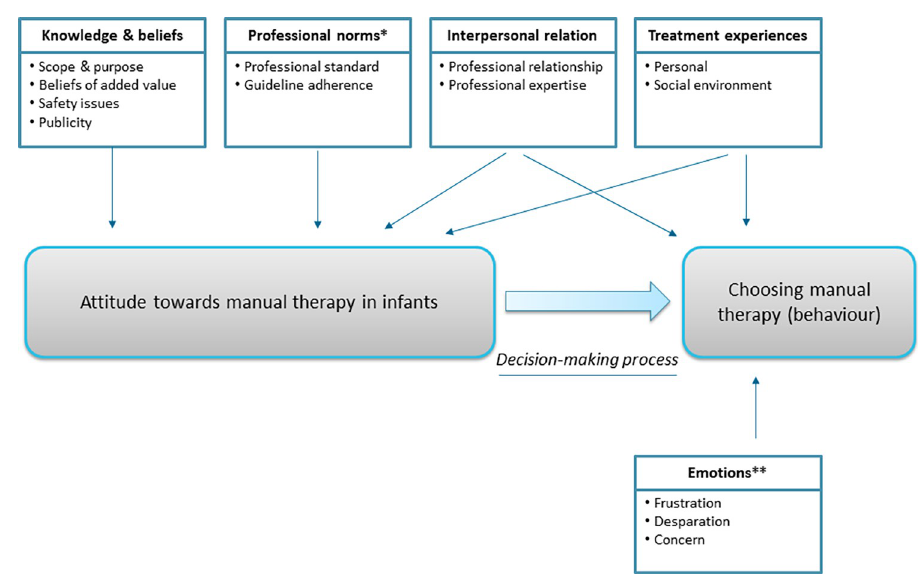
Fig 2. Conceptual model of factors related to attitude towards manual therapy in infants. * Factor that solely count for healthcare professionals, ** factor that solely count for parents.